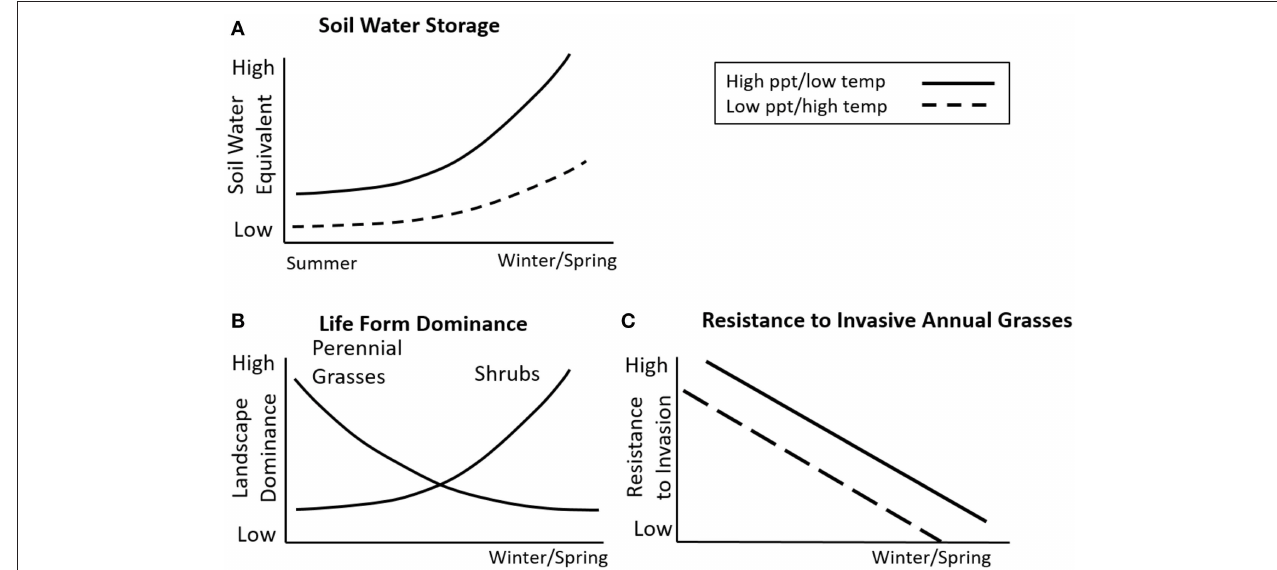
FIGURE 3 | Changes in soil water storage, life form dominance and resistance to invasive annual grasses as seasonality of precipitation transitions from primarily summer to winter in the Cold Deserts of western North America. (A) Soil water storage increases as the proportion of winter/spring precipitation increases and these changes are relatively greater for areas with relatively high precipitation and low temperature. (B) Landscape dominance of perennial native grasses is highest with primarily summer precipitation; shrub dominance is greatest with primarily winter/spring precipitation. (C) Resistance to invasive annual grasses is higher in areas where soil water storage is low and perennial grasses dominate largely due to strong resource competition. Decreases in effective precipitation can increase resource fluctuations and lower resistance to invasive annual grasses. At more local scales, resistance also is influenced by resource availability and disturbance. Figure modified from Chambers et al.